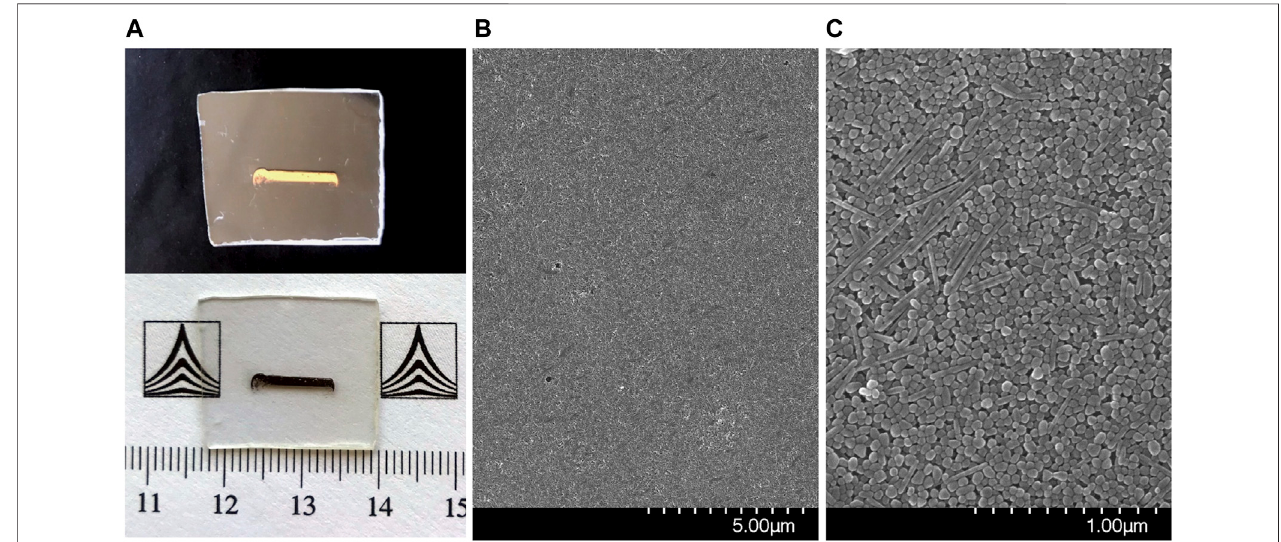
FIGURE 3 | (A) Photographs of the AgNP fi lm under different background and lighting conditions; (B,C) SEM images of the AgNP fi lms.